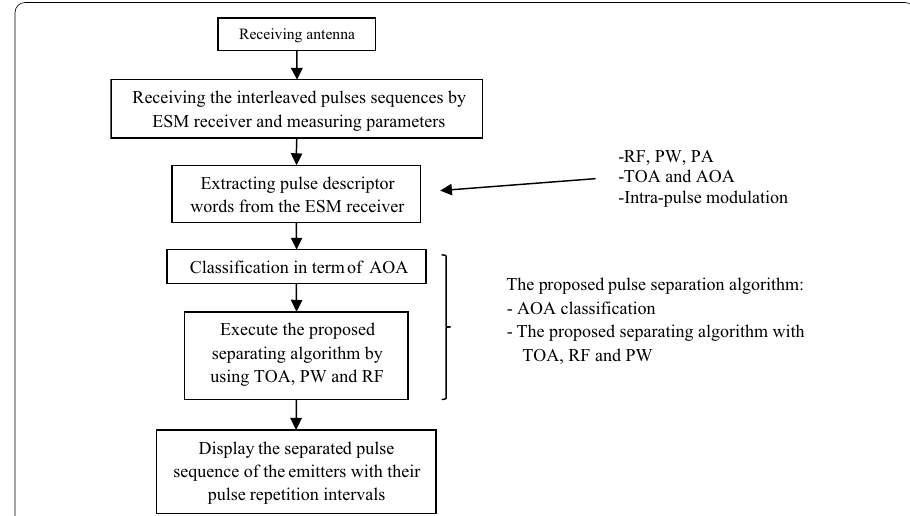
Fig. 2 General format for performing multi-parameter pulse